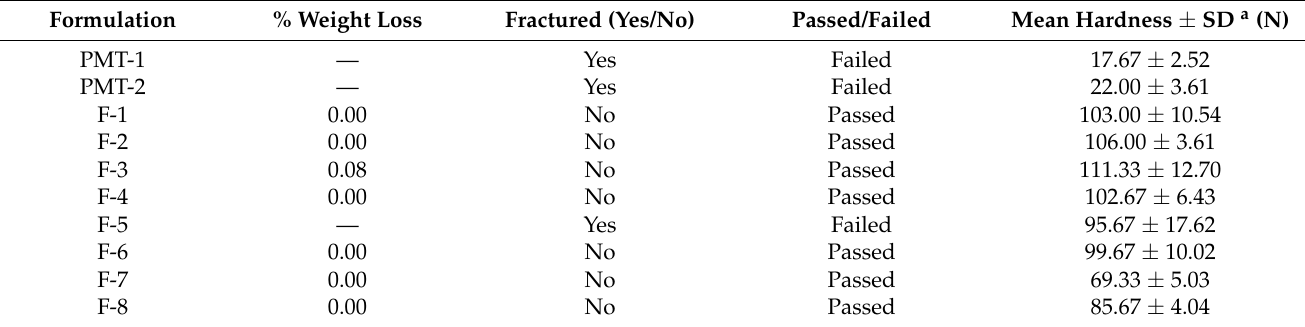
Table 4. Friability and tablet hardness test results of all formulations.